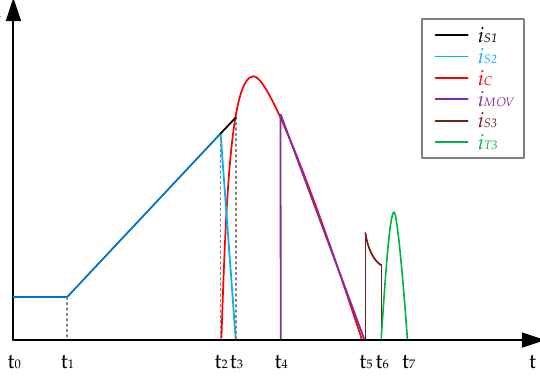
Figure 2. Current waveforms of the proposed HCB topology.